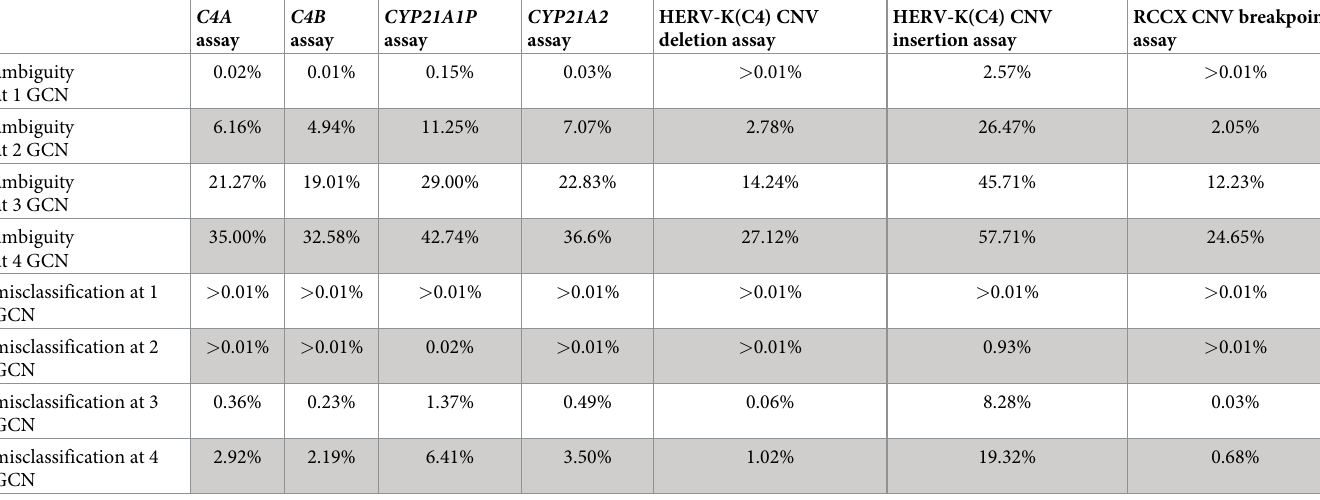
Table 1. Estimated ambiguity and misclassification rates of different qPCR assays for RCCX CNV at different gene copy numbers